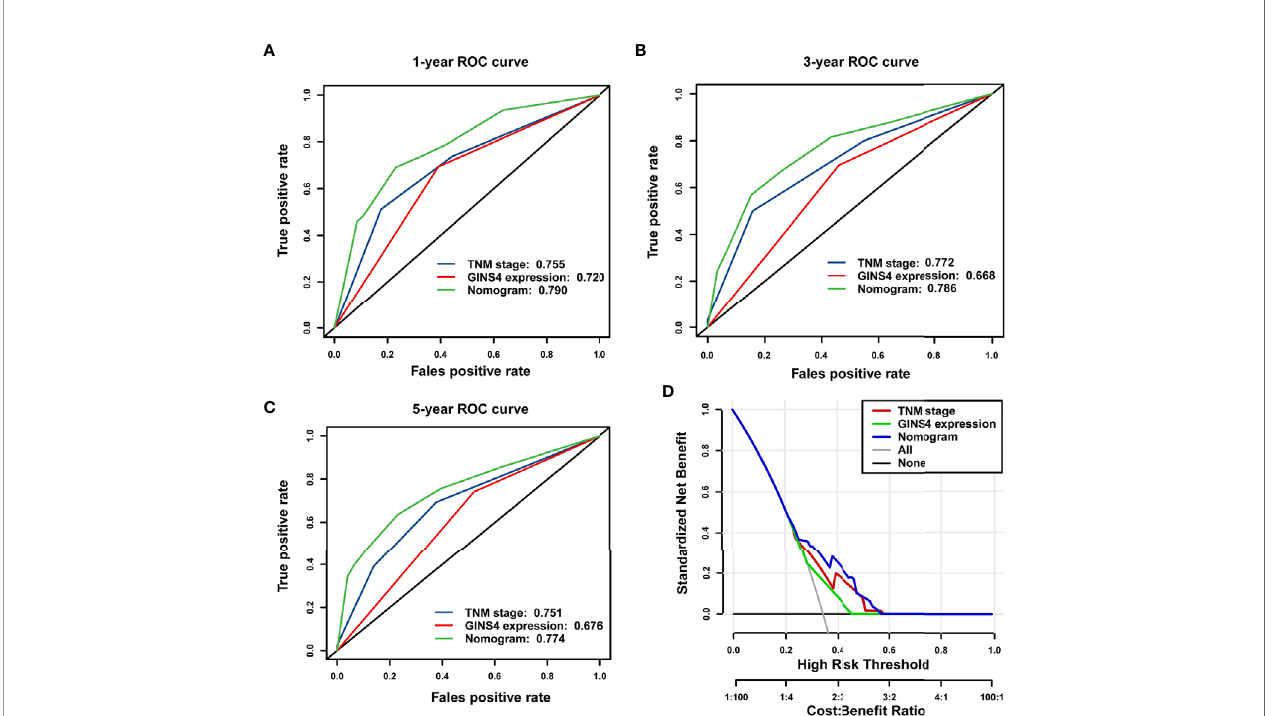
FIGURE 10 | The nomogram model shows a relatively desirable predictive accuracy and clinical utility to predict OS of 371 HCC patients from the TCGA database. The time- dependent ROC demonstrated the AUC values of the nomogram, TNM stage, and GINS4 expression level at (A) 1-year, (B) 3-year, and (C) 5-year OS of HCC patients. (D) DCA for evaluating the clinical utility of nomogram model, TNM stage, and GINS4 expression level in predicting the OS of HCC cases. The x-axis revealed the range of threshold probabilities and the y-axis showed the NB. The gray line farthest left indicated all strategies. The horizontal black line represented none strategy. OS, overall survival; ROC, the receiver operating characteristic; DCA, Decision curve analysis; AUC, the area under the curve; NB, net bene fi t.